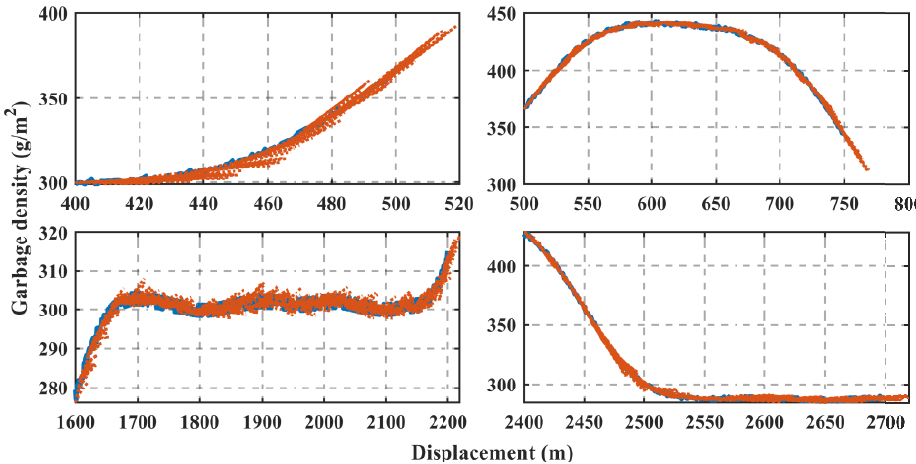
Figure 19. Prediction of the NARNN.